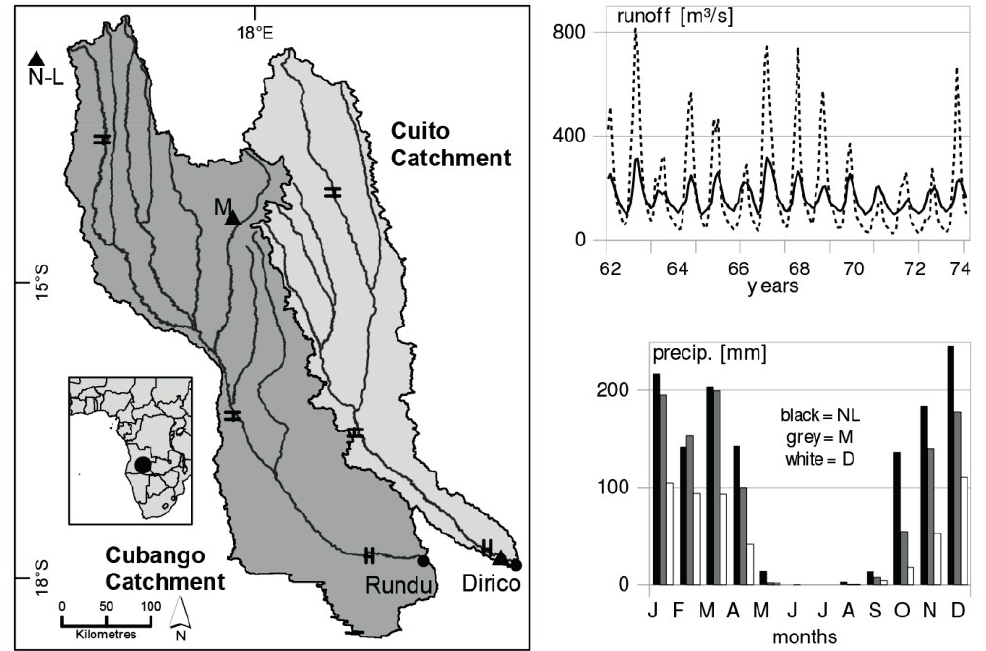
Fig. 1 Overview of the study site: observed monthly runoff for the Cubango (dotted) and the Cuito River for 1962–1975; location of the catchments and gauging stations; mean monthly precipitation (1962–1974) for Nova Lisboa (NL), Menongue (M) and Dirico (D) (triangles). Position of transverse valley profiles shown in Fig. 3 are marked on the